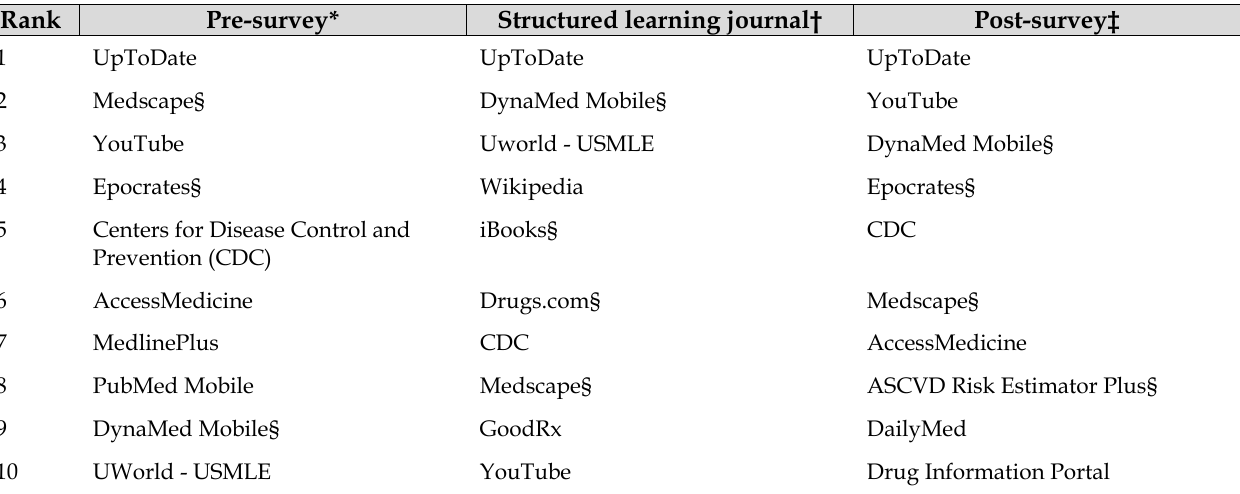
Table 2 Participant resource use